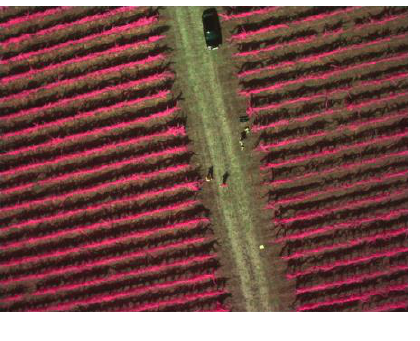
Figure 18. Ortophoto from multi-spectral image July 31 st 2017